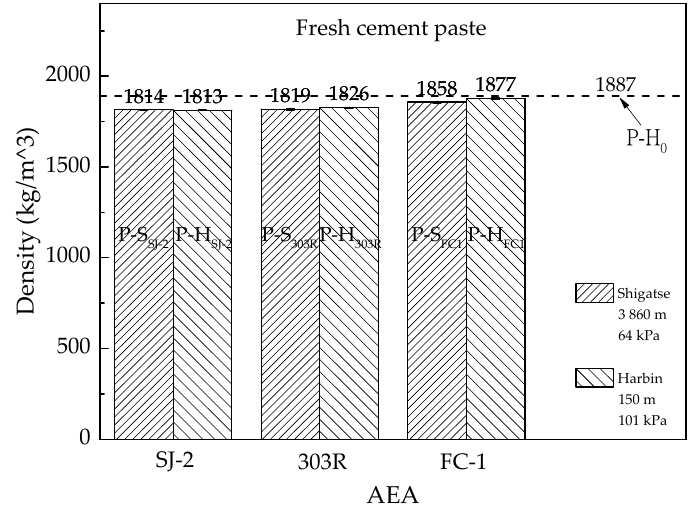
Figure 1. Density comparison of fresh air-entrained cement paste prepared in different atmospheric pressures. AEA, air-entraining agent.